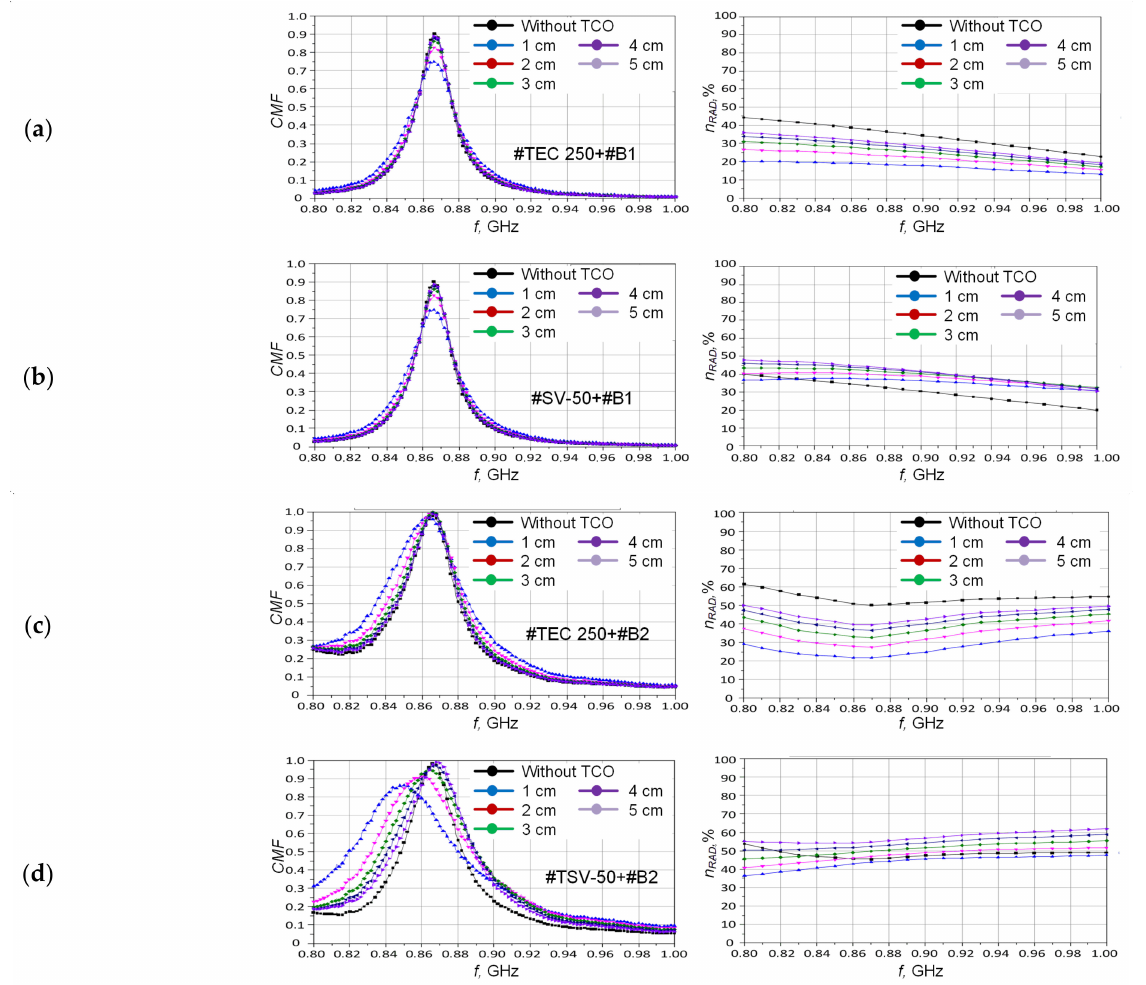
Figure 17. CMF and radiation efficiency n RAD vs. separation distance between TCO and antenna radiator in arrangements: ( a ) #TEC 250+#B1; ( b ) #SV-50+#B1; ( c ) #TEC 250+#B2; ( d )